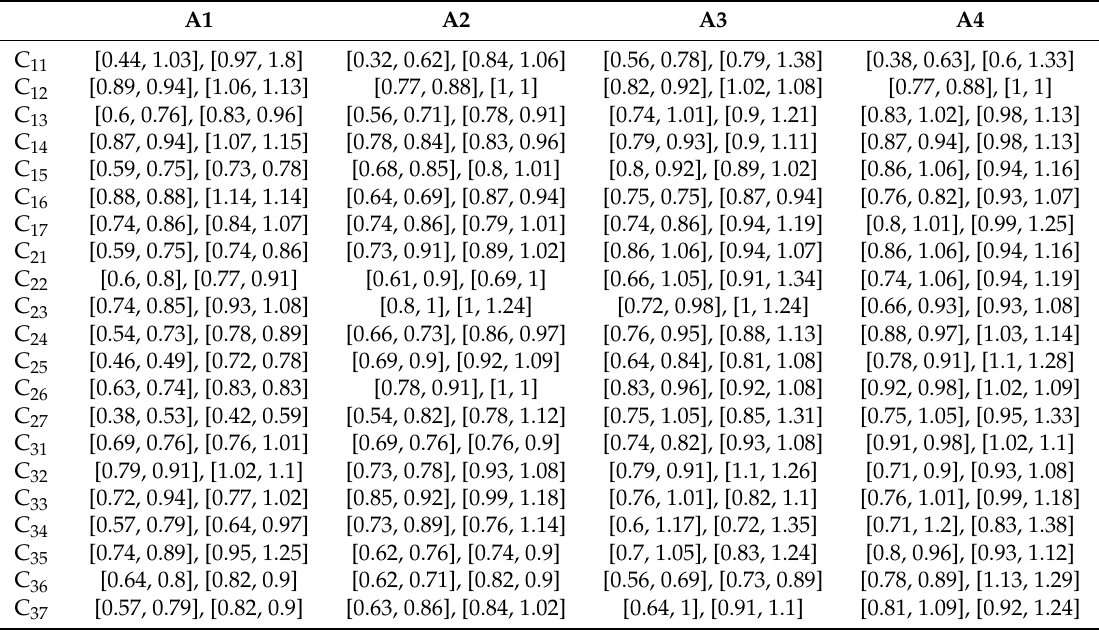
Table 4. Normalized interval rough matrix.